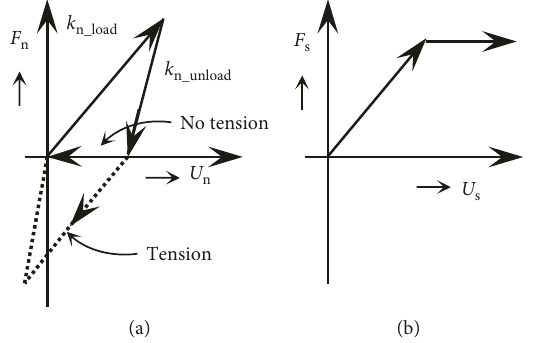
Figure 1: Constitutive relation of the hysteretic model: (a) normal direction; (b) shear